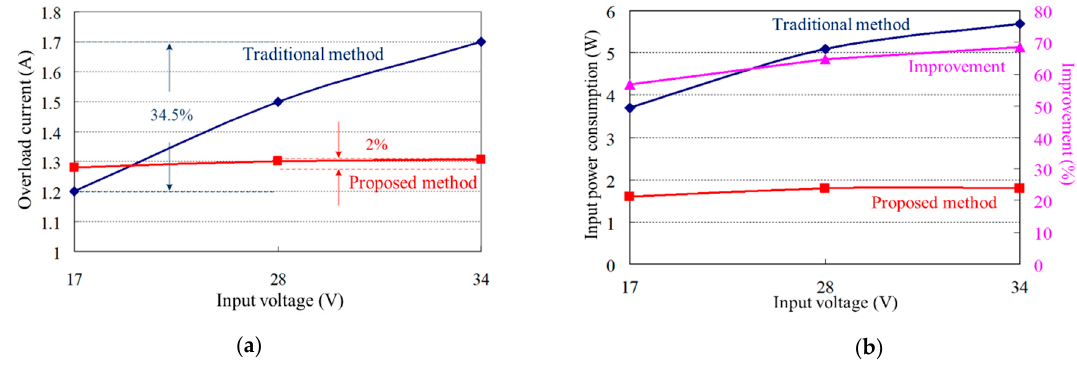
Figure 10. Experimental results ( a ) Overload current under different input voltage, ( b ) Input power consumption under different input voltage.